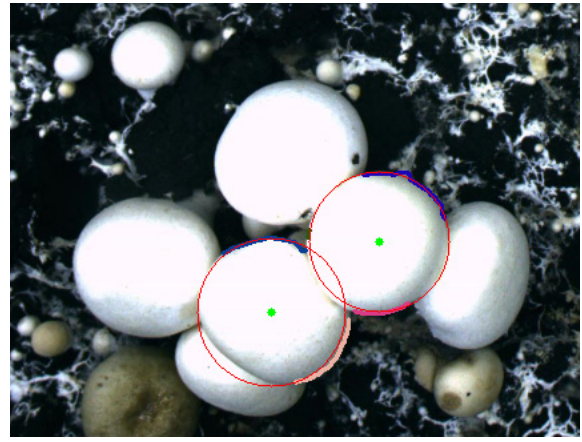
Figure 15. Circle outline of Agaricus bisporus.